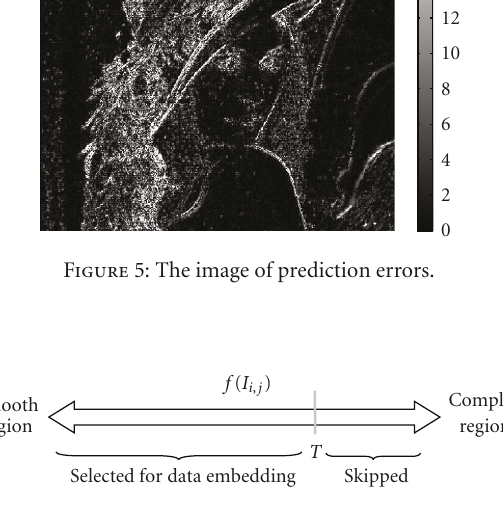
Figure 6: The selective embedment mechanism.